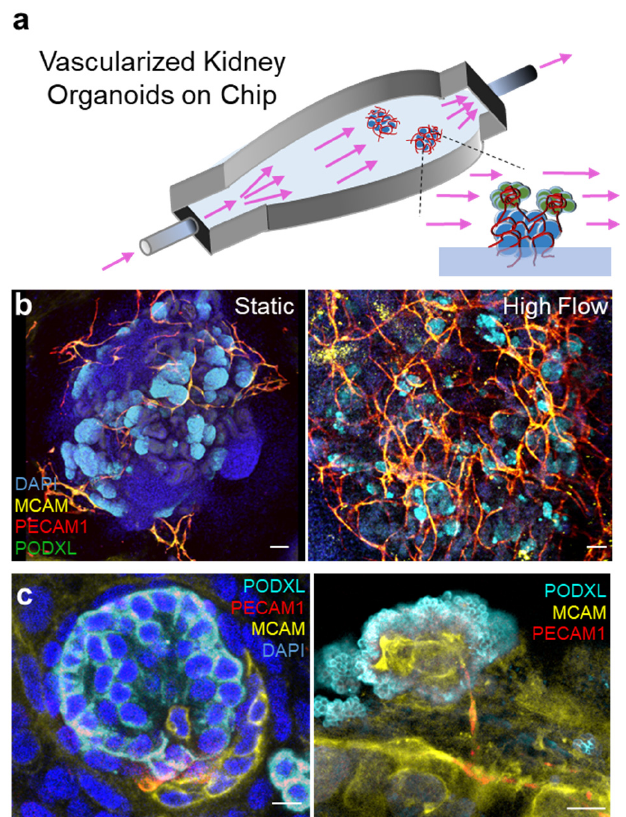
Figure 1. Vascularized kidney organoids cultured on millifluidic chips. ( a ) An illustration showing the experimental set up of the organoids-on-chip system. Arrows: fluid flow. ( b ) Whole organoid images showing glomeruli (PODXL) and vessels (MCAM/PECAM1) in static and perfused organoids. ( c ) High magnification images demonstrating vessel invasion into organoid glomeruli in perfused kidney organoids. Images adapted with permission from [14].